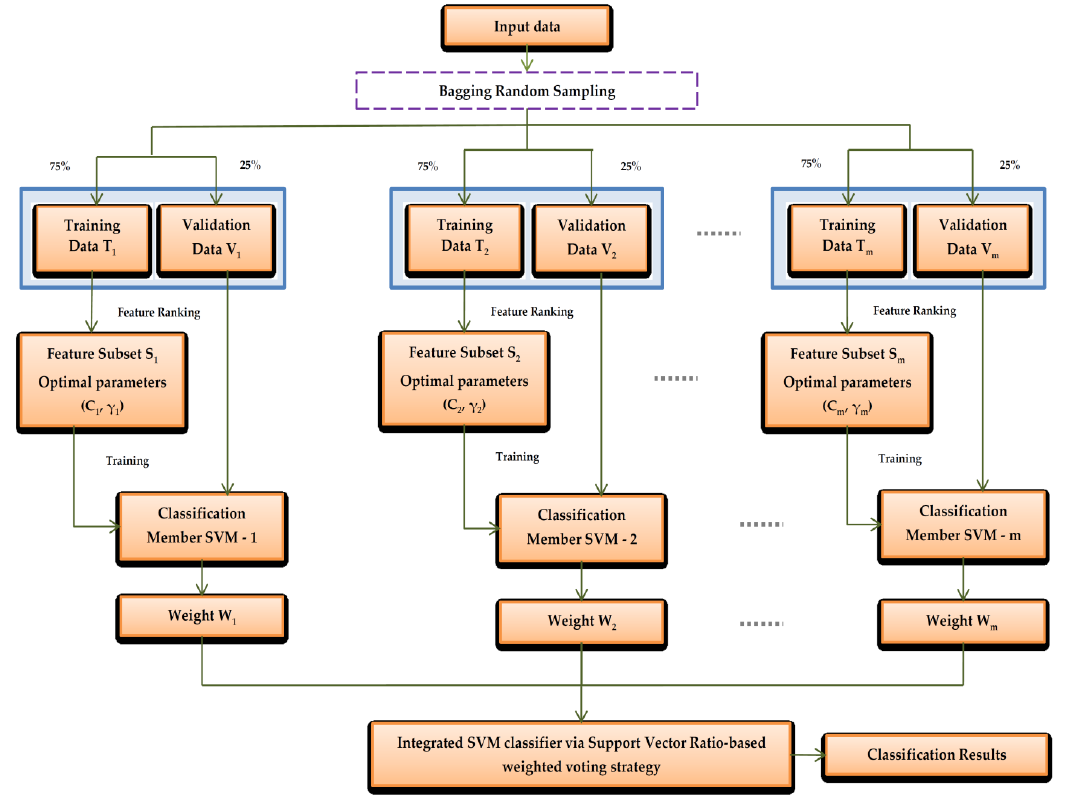
Figure 1. Proposed support vector ratio-based integrated multistage support vector machine classification model—architectural framework.